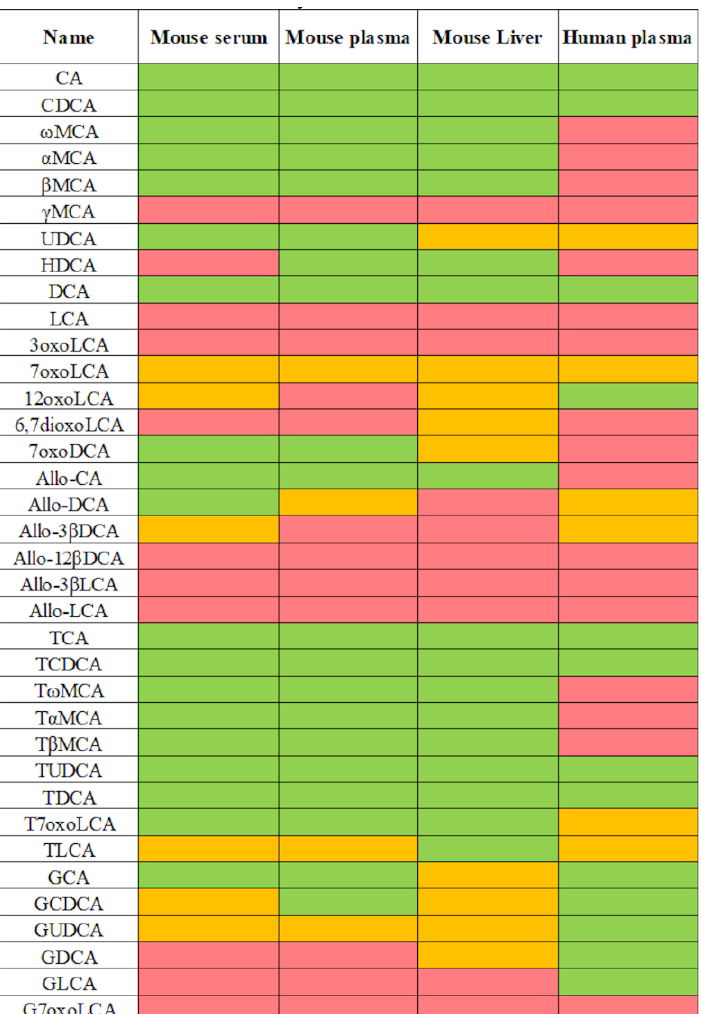
Figure 2. List of bile acids included in the LC-MS/MS method for quantification. The newly established method was applied to different matrices including plasma of human and mouse, as well as mouse serum and liver tissue. Colors indicate compound detection and quantification: Green: Compound detected in samples used for this test. Yellow: Compound detected at a very low concentration, close to LOQ or not detected in all samples tested. Red: Compound not detected in most samples.